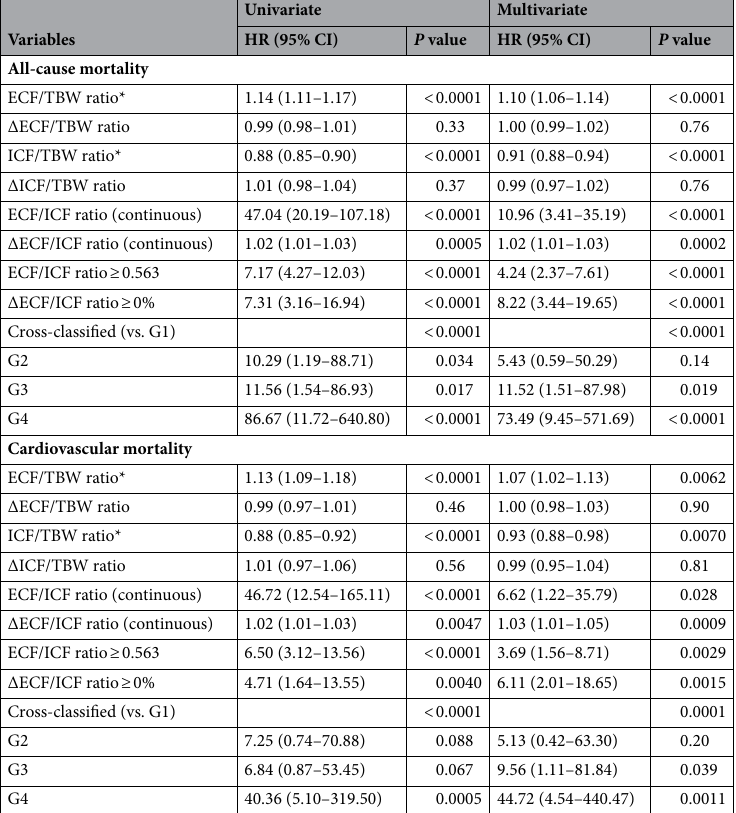
Table 2. Cox proportional hazards analysis of the ECF/ICF ratio and the ΔECF/ICF ratio for all-cause and cardiovascular mortality. *Per 0.01 increased. ECF, extracellular fluid; ICF, intracellular fluid; TBW, total body water; ΔECF/TBW ratio, annual change in ECF/TBW ratio; ΔICF/TBW ratio, annual change in ICF/TBW ratio; ΔECF/ICF ratio, annual change in ECF/ICF ratio. G1, ECF/ICF ratio < 0.563 and ΔECF/ICF ratio < 0%; G2, ECF/ICF ratio ≥ 0.563 and ΔECF/ICF ratio < 0%; G3, ECF/ICF ratio < 0.563 and ΔECF/ICF ratio ≥ 0%; G4, ECF/ICF ≥ 0.563 and ΔECF/ICF ≥ 0%. All-cause mortality: adjusted by age, sex, history of cardiovascular disease, creatinine, phosphorus, C-reactive protein, high-density lipoprotein cholesterol, cardiothoracic ratio, and the geriatric nutritional risk index. Cardiovascular mortality: adjusted by age, sex, history of cardiovascular disease, phosphorus, cardiothoracic ratio, and the geriatric nutritional risk